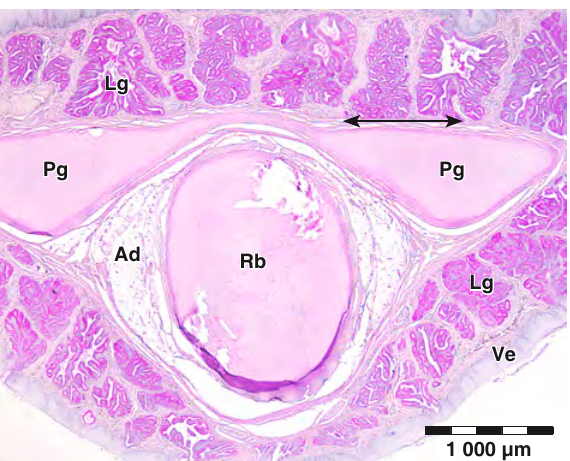
FIG. 10 Cross section of the middle of the tongue body showing